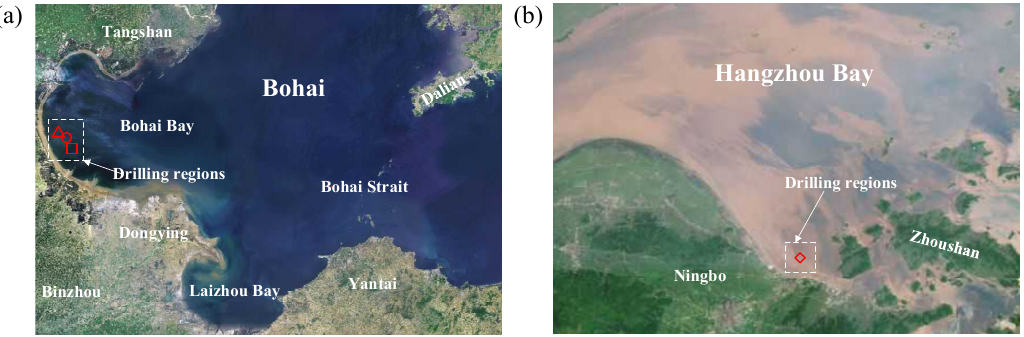
Figure 1. Geographical locations of the boreholes: ( a ) Bohai Bay and ( b ) Hangzhou Bay. Table 2. Representative physical parameters of the marine clays.